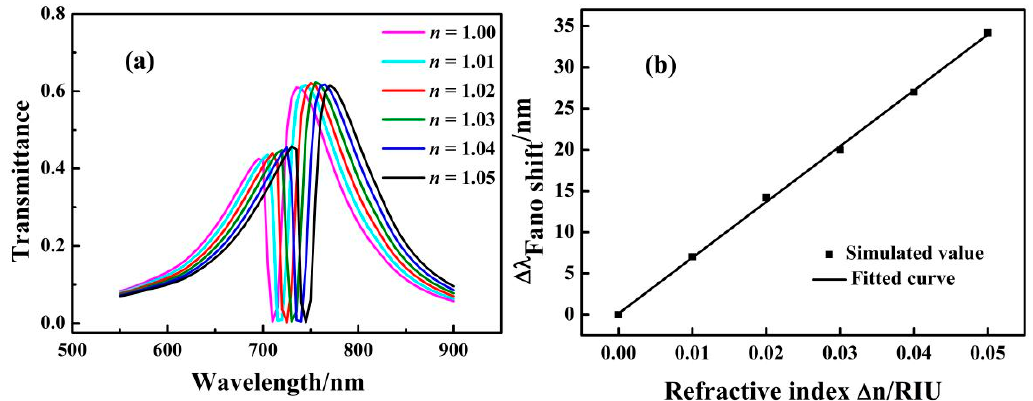
Figure 4. ( a ) Transmission spectra for different refractive indexes n ; ( b ) Fitting curve of Fano resonance peak shift caused by the change in the refractive index of Δ n .